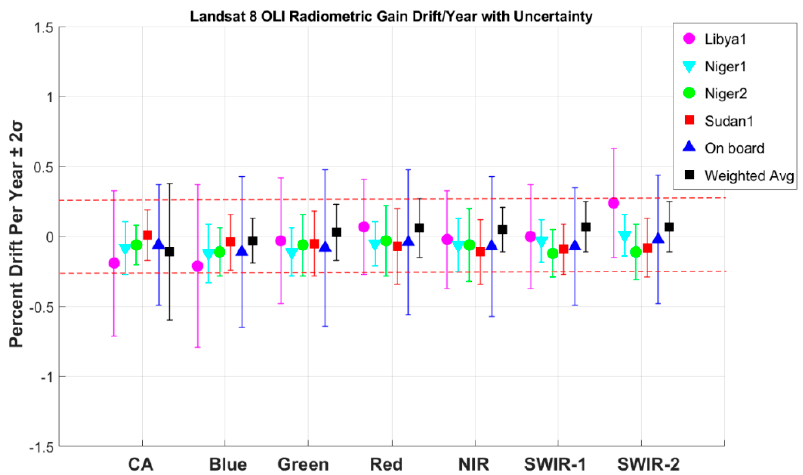
Figure 5. Estimates of long-term drift for Landsat 8 OLI as measured by observation of PICS and an onboard diffuser. By averaging several PICS together, results are statistically indistinguishable from onboard methods. Compare the weighted PICS averages (black squares), inversely weighted by their uncertainty, to the onboard diffuser (blue triangle). Figure courtesy of South Dakota State University Image Processing Laboratory.